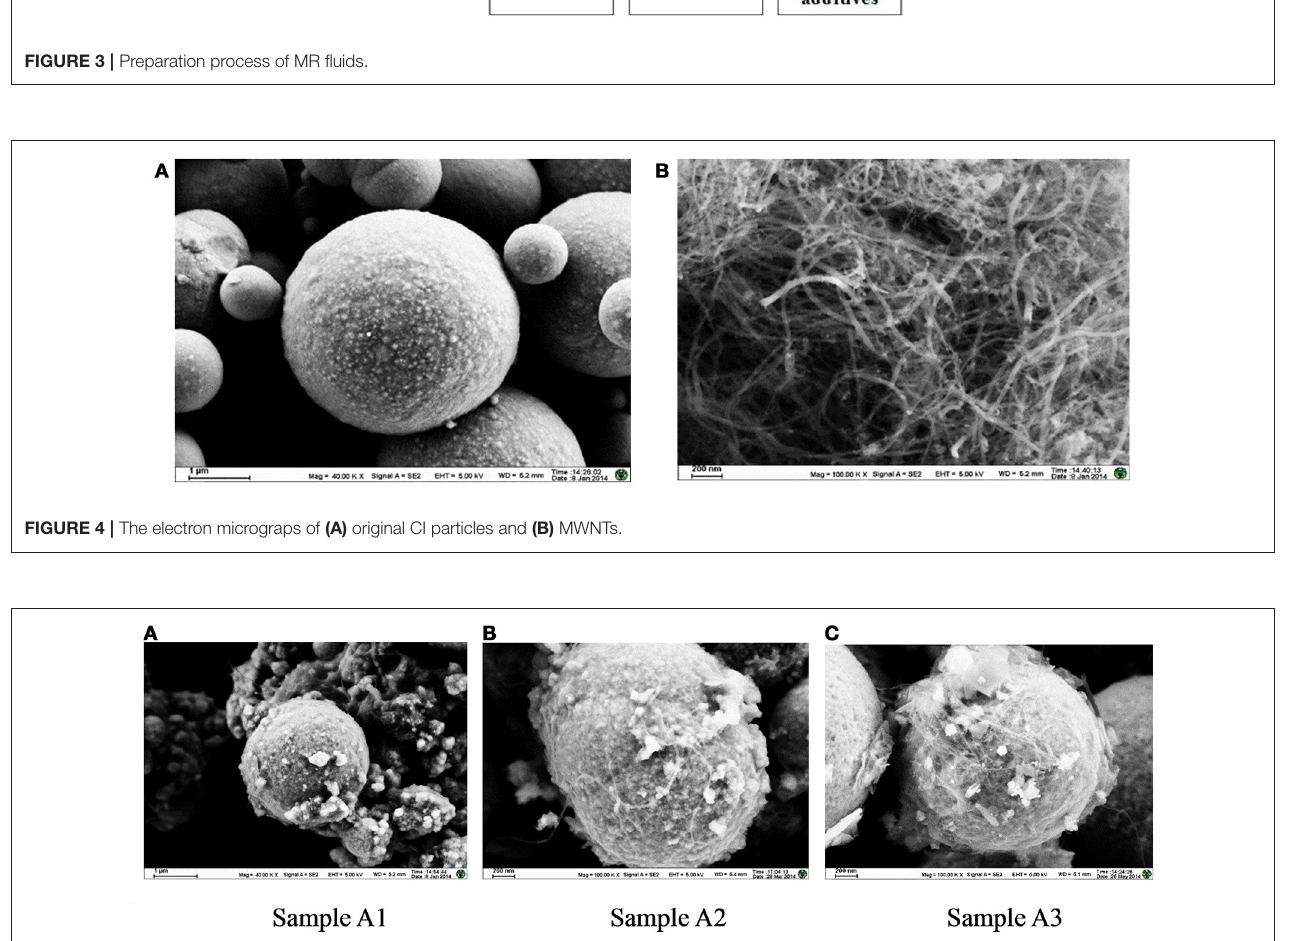
FIGURE 5 | The electron micrographs of composite particles with different dosages of grafting agent.